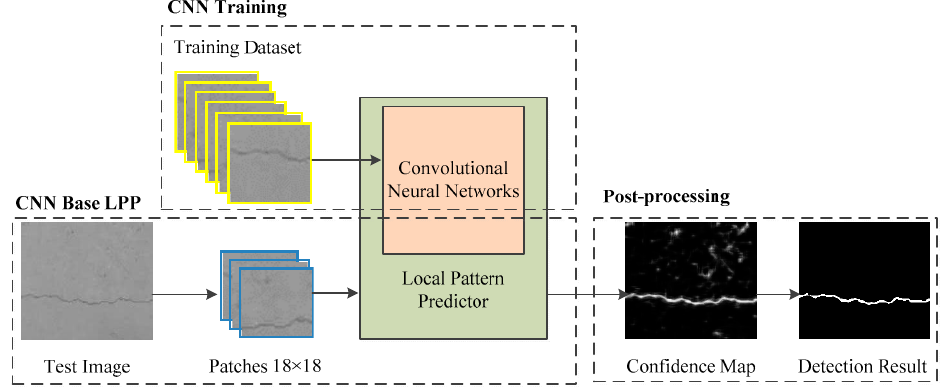
Figure 1. Overview of the proposed algorithm.